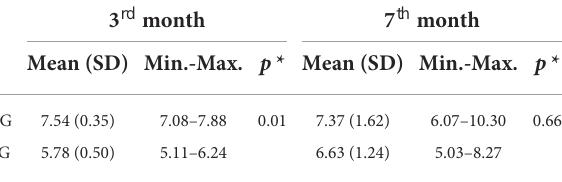
TABLE 1 Pulp cell density measures for the control group (CG) and the exposed group (EG) at the 3 rd month and the 7 th month. 3 rd month 7 th